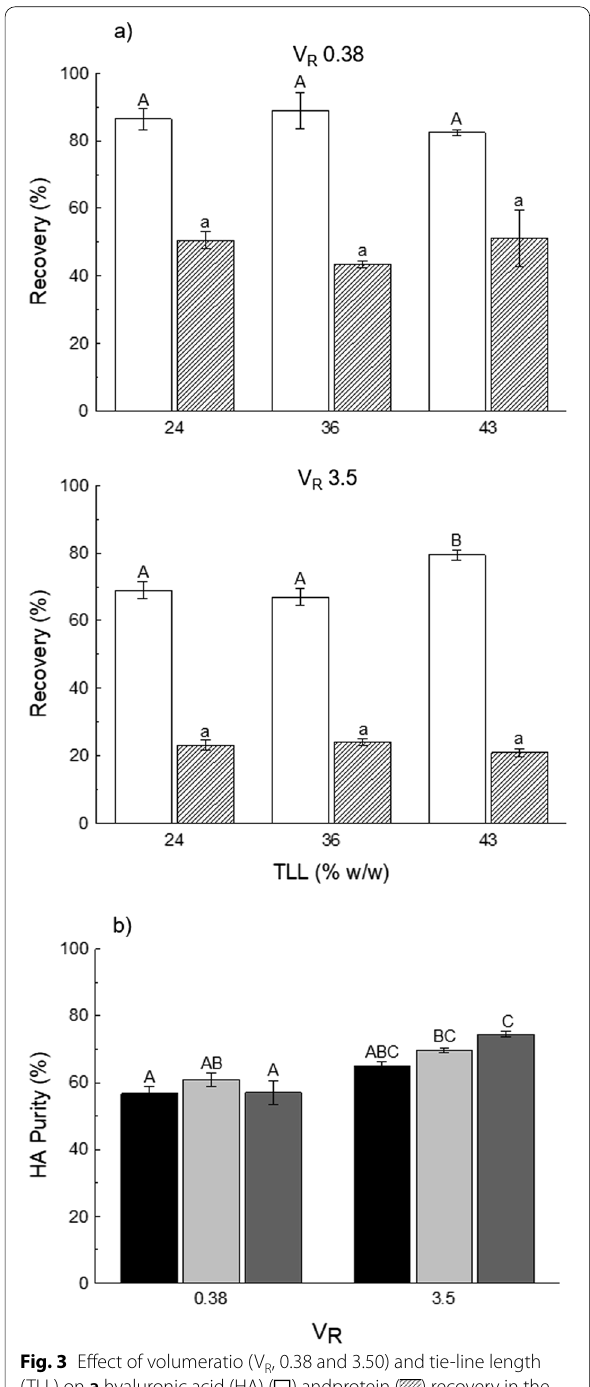
Fig. 3 Effect of volumeratio (V R , 0.38 and 3.50) and tie‑line length (TLL) on a hyaluronic acid (HA) ( □ ) andprotein ( ) recovery in the bottom phase of polyethylene glycol (PEG)8000–citrate aqueous two‑phase systems (ATPS); and on b HA purity (TLL 24 ( ), 36 ( ), and 43 ( ) % w/w). The crudeextract (molecular weight: 3 MDa) was loaded to the ATPS at a finalconcentration of 10% (w/w). Bars represent the sample mean SEMof experimental triplicates. Bars ± within the same graph that do not share thesame uppercase (HA) or lowercase (protein) letter are significantly different (p <